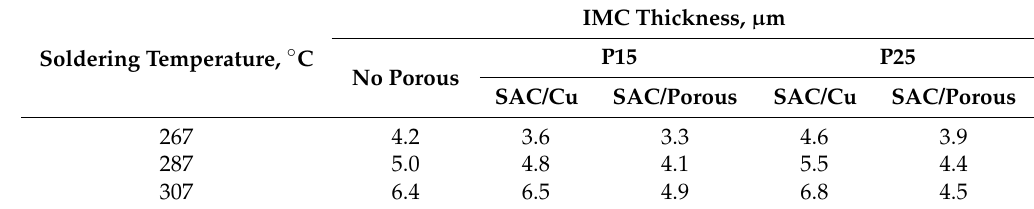
Table 5. Average thickness of intermetallic compound (IMC) layer for every sample. IMC Thickness, µ m Soldering Temperature, ◦ C No Porous